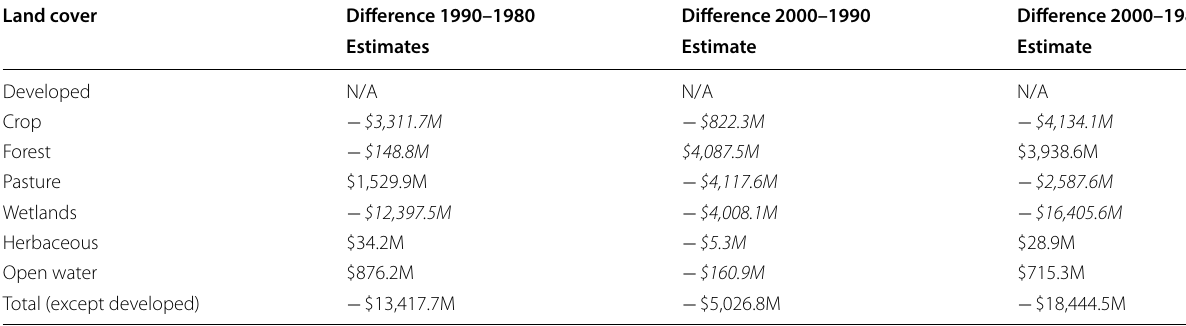
Table 7 Acreage and costs difference using the maximum values Land